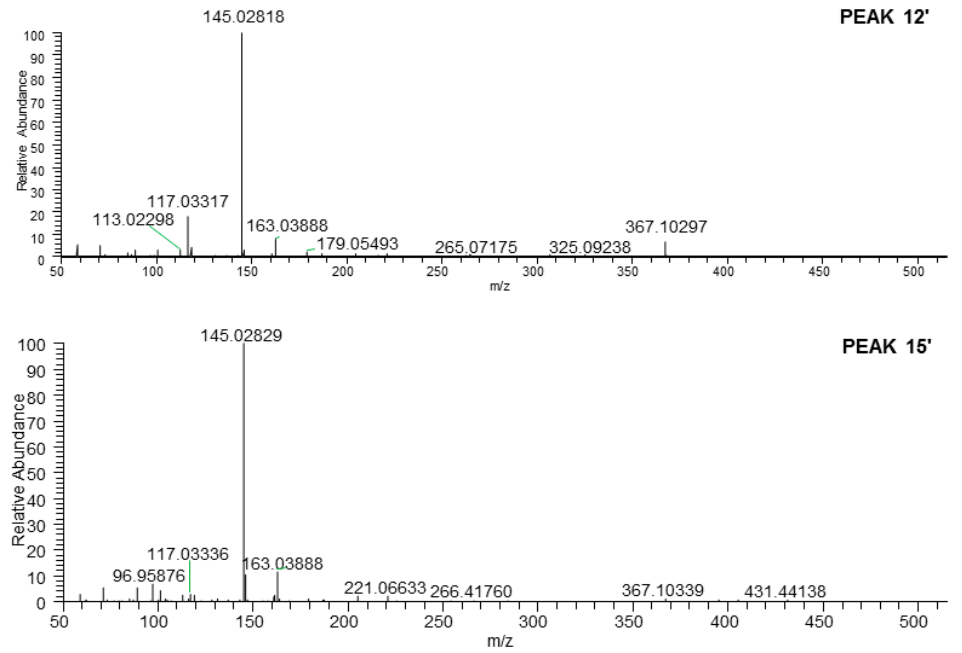
Figure 14. The tandem MS of the [M − H] − ions for peaks 12’ and 15’.